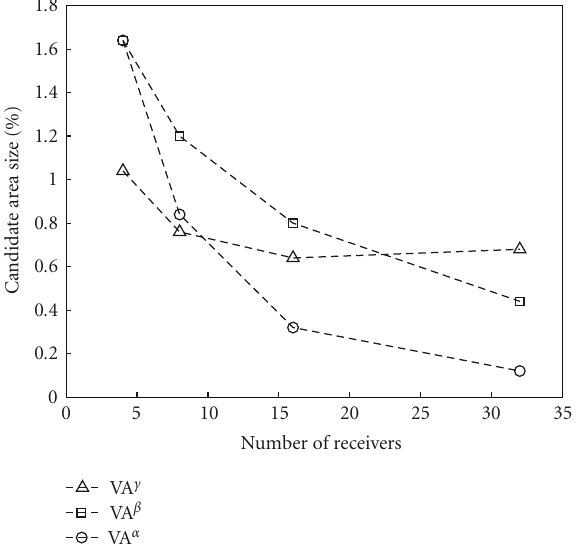
Figure 7: Vehicular candidate area size for C = 0 . 95.